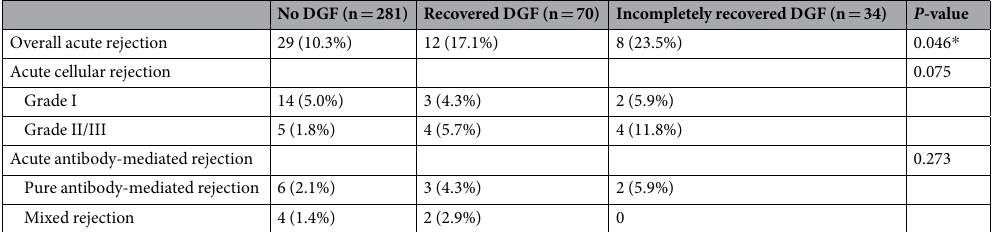
Table 4. Histologic features of acute rejection. * Post hoc Bonferroni: P < 0.05 in comparison between control vs. incompletely recovered